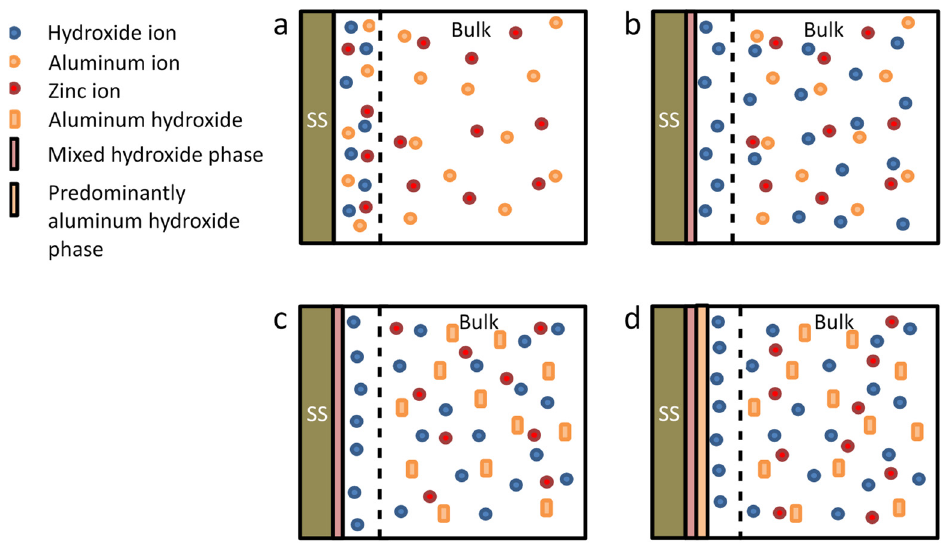
Figure 4. Film formation process of the mixed hydroxide phase and top aluminum hydroxide layer for the electrodeposited zaccagnaite coating on stainless-steel substrate, ( a ) generation of hydroxides at the electrode, ( b ) deposition of metal hydroxides and diffusion of unconsumed hydroxides away from the electrode surface, ( c ) pH increases in the bulk solution resulting in aluminum hydroxide precipitation, and ( d ) aluminum hydroxide precipitate formed in bulk deposits onto mixed hydroxide layer.